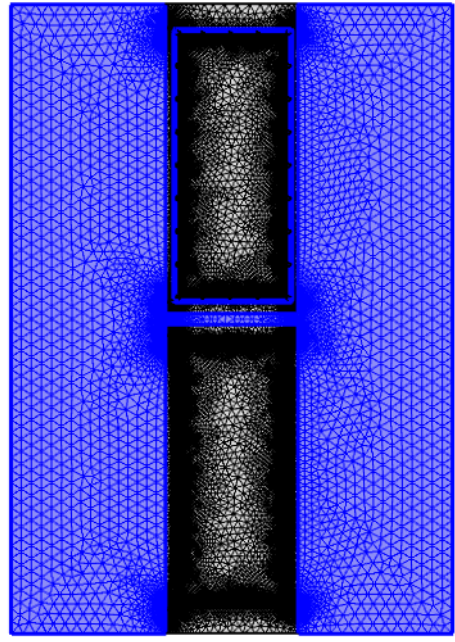
Figure 21. The meshing of the model.